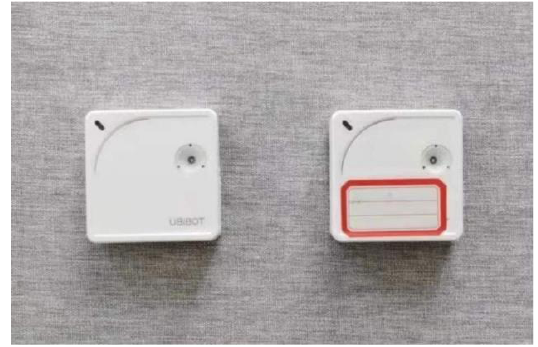
Figure 9. Actual picture of sensors.